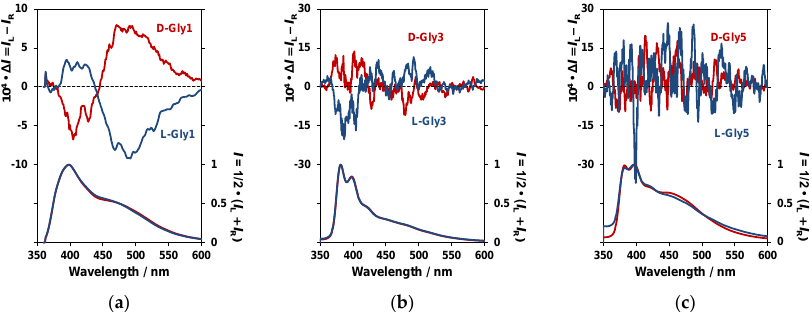
Figure 4. CPL (upper panel) and PL (lower panel) spectra of ( a ) D -Gly1 / L -Gly1 [13]; ( b ) D -Gly3 / L -Gly3 ; ( c ) D -Gly5 / L -Gly5 in CHCl 3 (1.0 × 10 −4 M). D -isomer and L -isomer spectra are shown in red and blue, respectively. Path length = 1 mm.